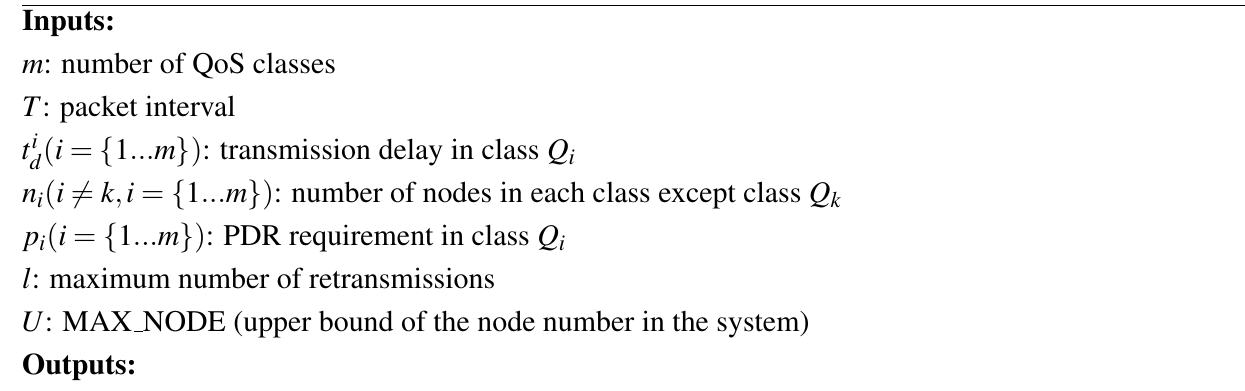
Algorithm 1 The Custom Greedy